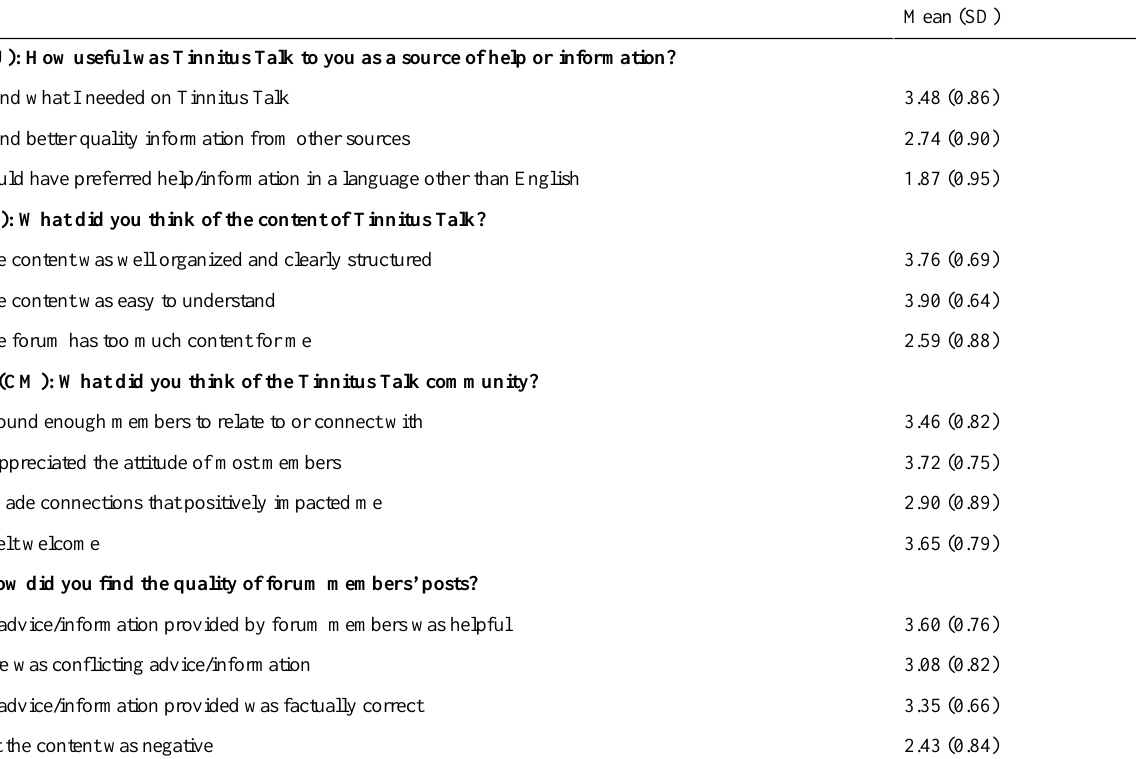
Table 4. Users’perceptions of Tinnitus Talk scored on a 5-point Likert scale (1=strongly disagree and 5=strongly